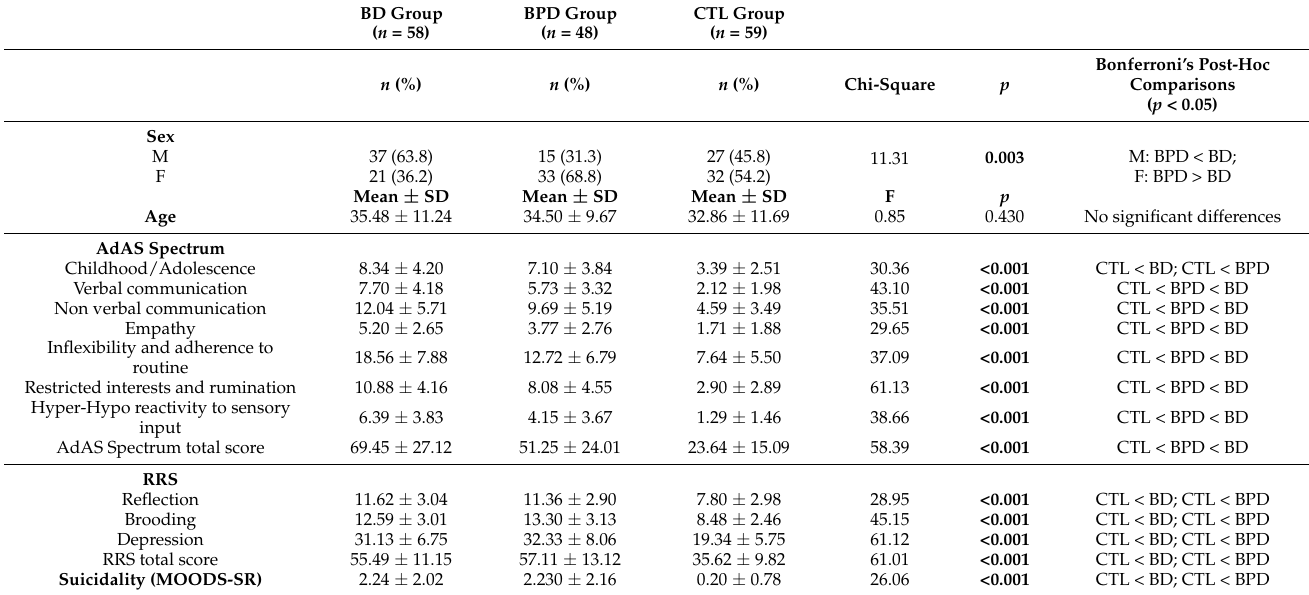
Table 1. Comparison of socio-demographic variables and psychometric instrument scores among groups.